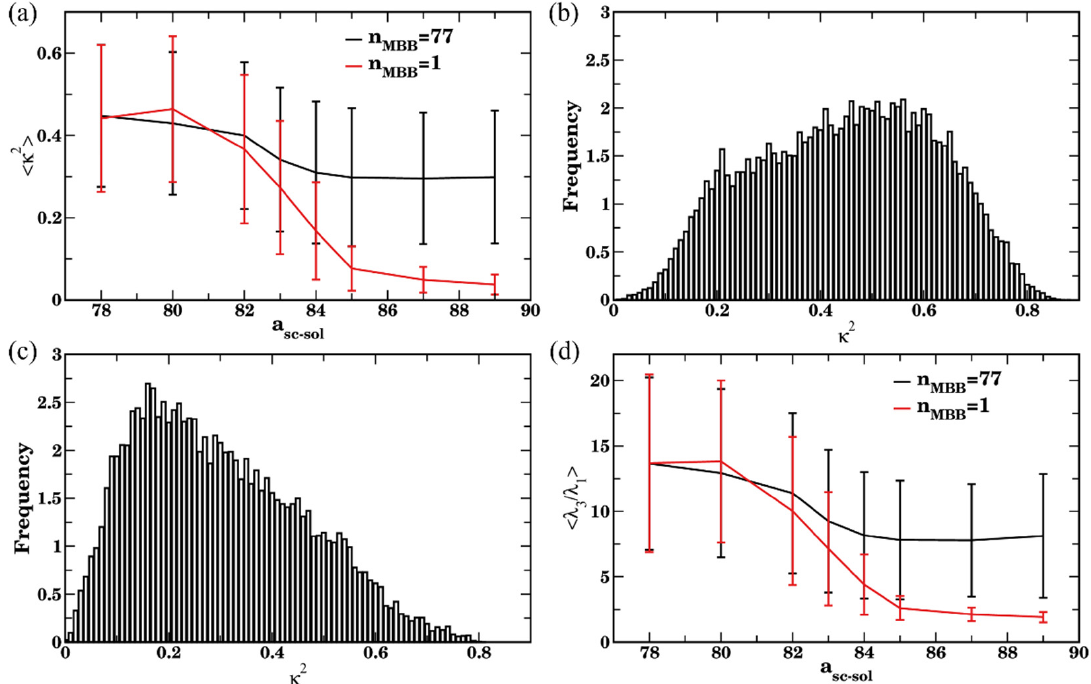
Figure 10. ( a ) Shape anisotropy κ 2 upon equilibration as a function of side chains affinity for n MBB = 77 (black curve) and for the single bottlebrush (red curve). ( b , c ) Distribution of the κ 2 in good solvent a sc-sol = 78 (in ( b )) and in poor solvent a sc-sol = 89 (in ( c )) for 77 bottlebrushes in four sets with the last 3 × 10 5 time steps. ( d ) Ratio of eigenvalues λ 3 / λ 1 upon equilibration as a function of side chains affinity for n MBB = 77 (black curve) and for the single bottlebrush (red curve). In ( a , d ), the data are averaged over all 77 bottlebrushes in four sets within the last 3 × 10 5 time steps (60 frames for each set), error bars represent standard deviation. In ( b , c ), data used to plot distributions includes relevant characteristics of all 77 bottlebrushes in four sets within the last 3 × 10 5 timesteps.